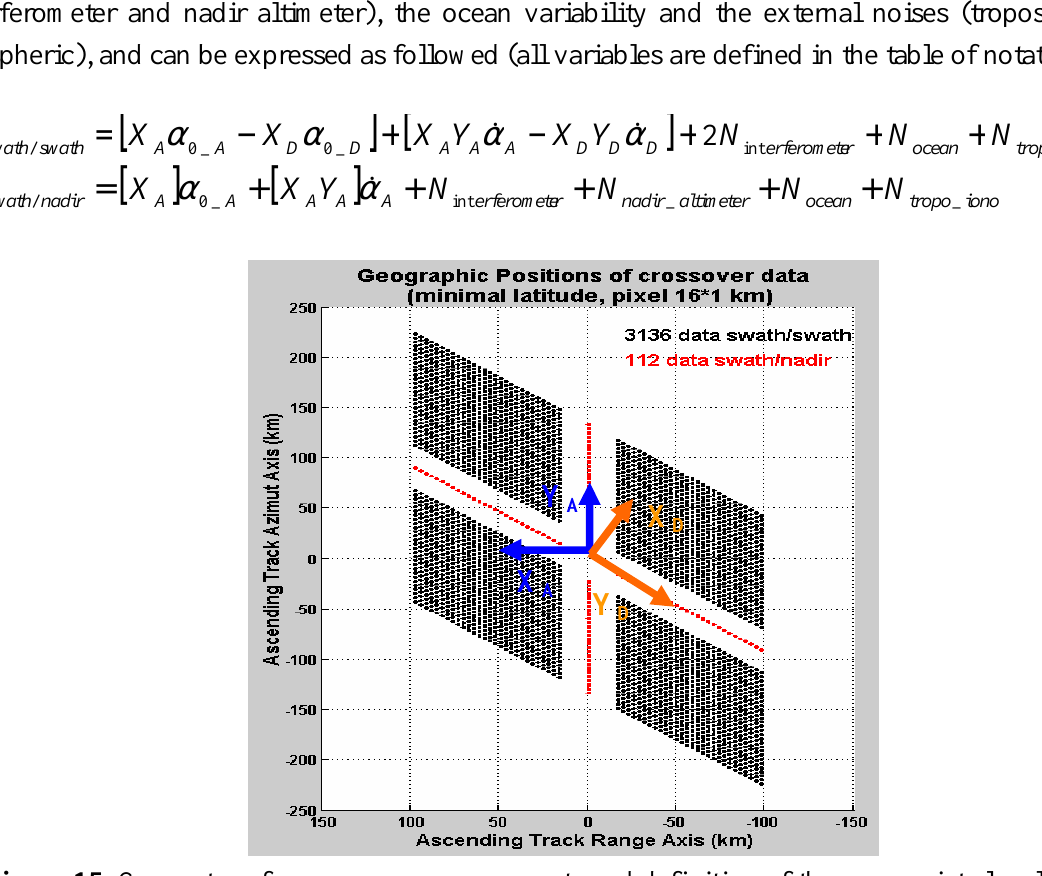
Figure 15. Geometry of crossovers measurements and definition of the appropriate local